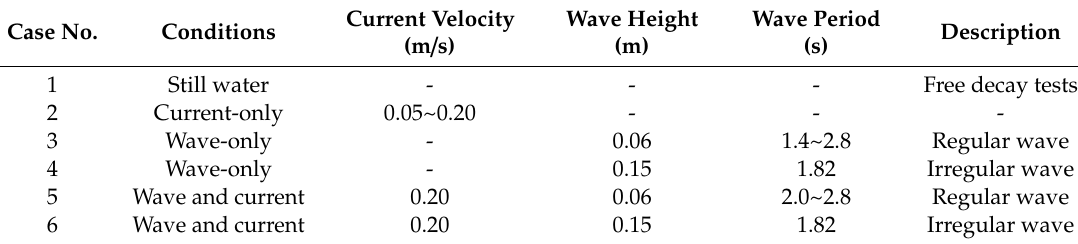
Figure 9. Arrangement of the experiment and layout of the mooring lines in the wave and current conditions. Table 4. Wave and current conditions in the experiments.